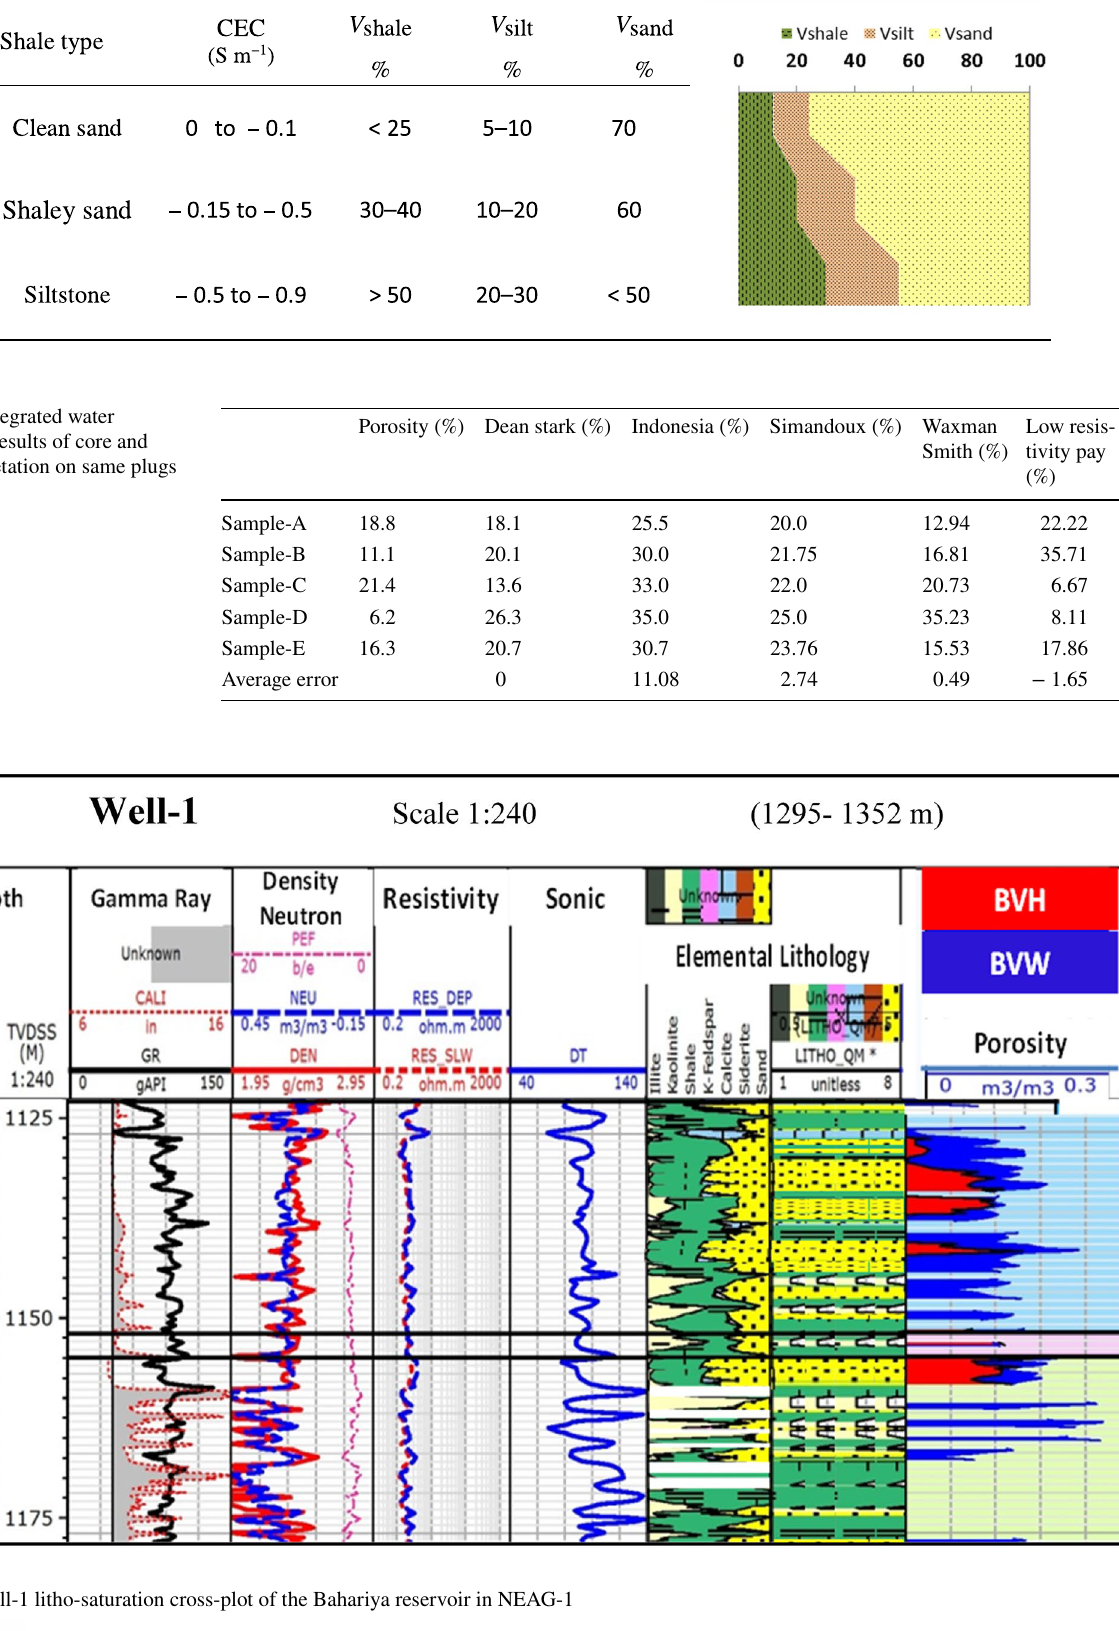
Fig. 14 Well-1 litho-saturation cross-plot of the Bahariya reservoir in